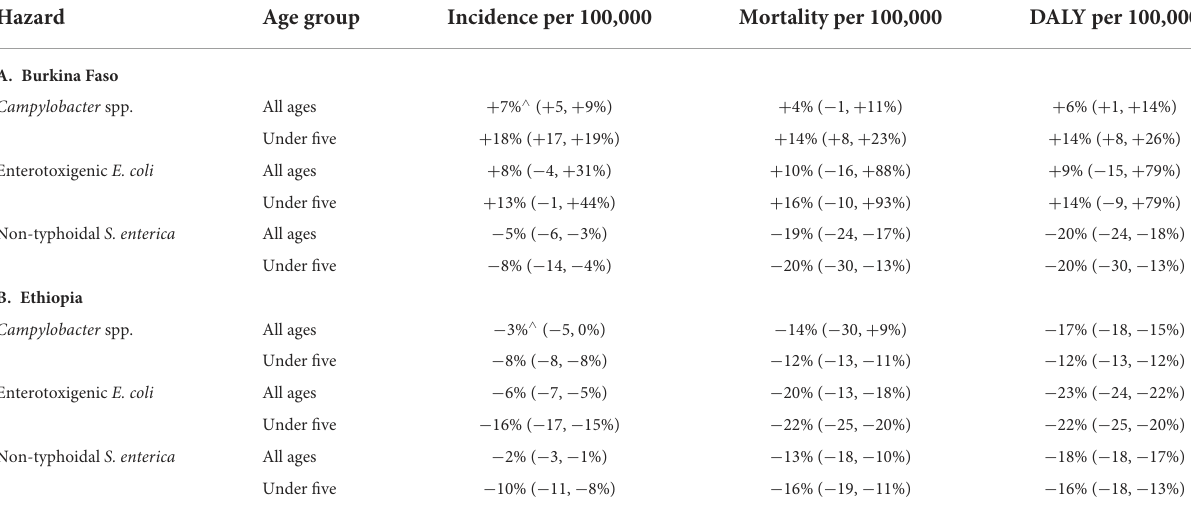
TABLE 3 Relative change for 2017 compared to 2010 of disease burden per 100,000 for three bacterial hazards in Burkina Faso and Ethiopia according to the Global Burden of Disease study (Kyu et al., 2018). Hazard Age group Incidence per 100,000 Mortality per 100,000 DALY per 100,000